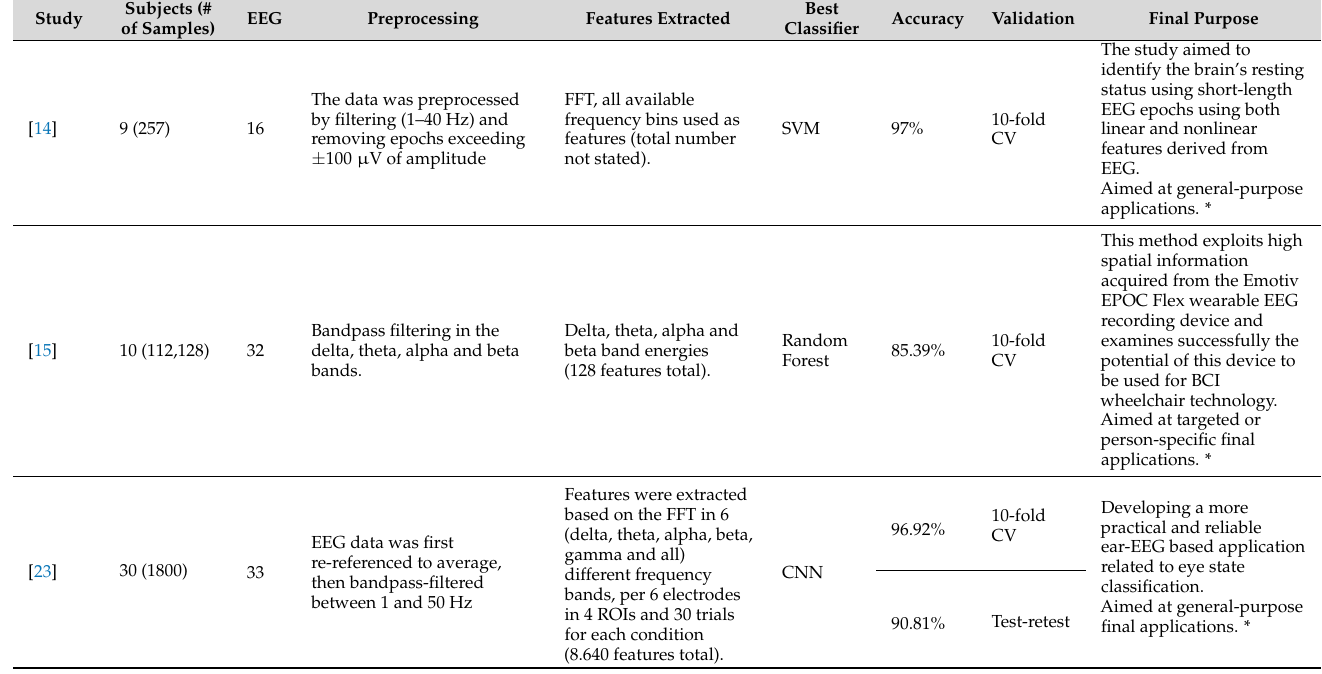
Table 3. Results of previous studies classifying EC and EO states from resting state EEG